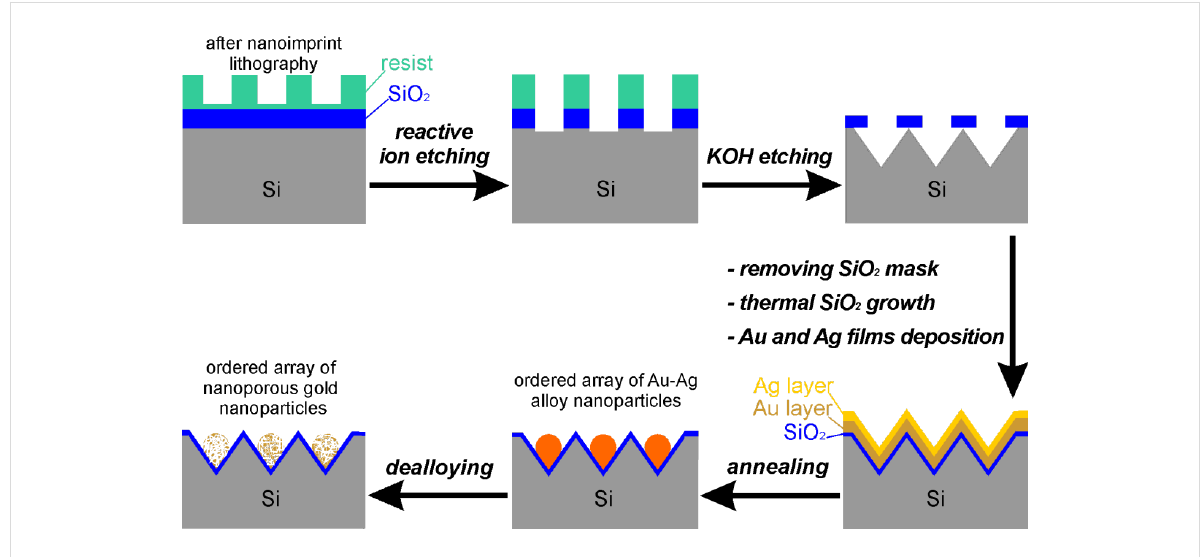
Figure 1: Schematics of the fabrication process for an ordered array of nanoporous gold nanoparticles.